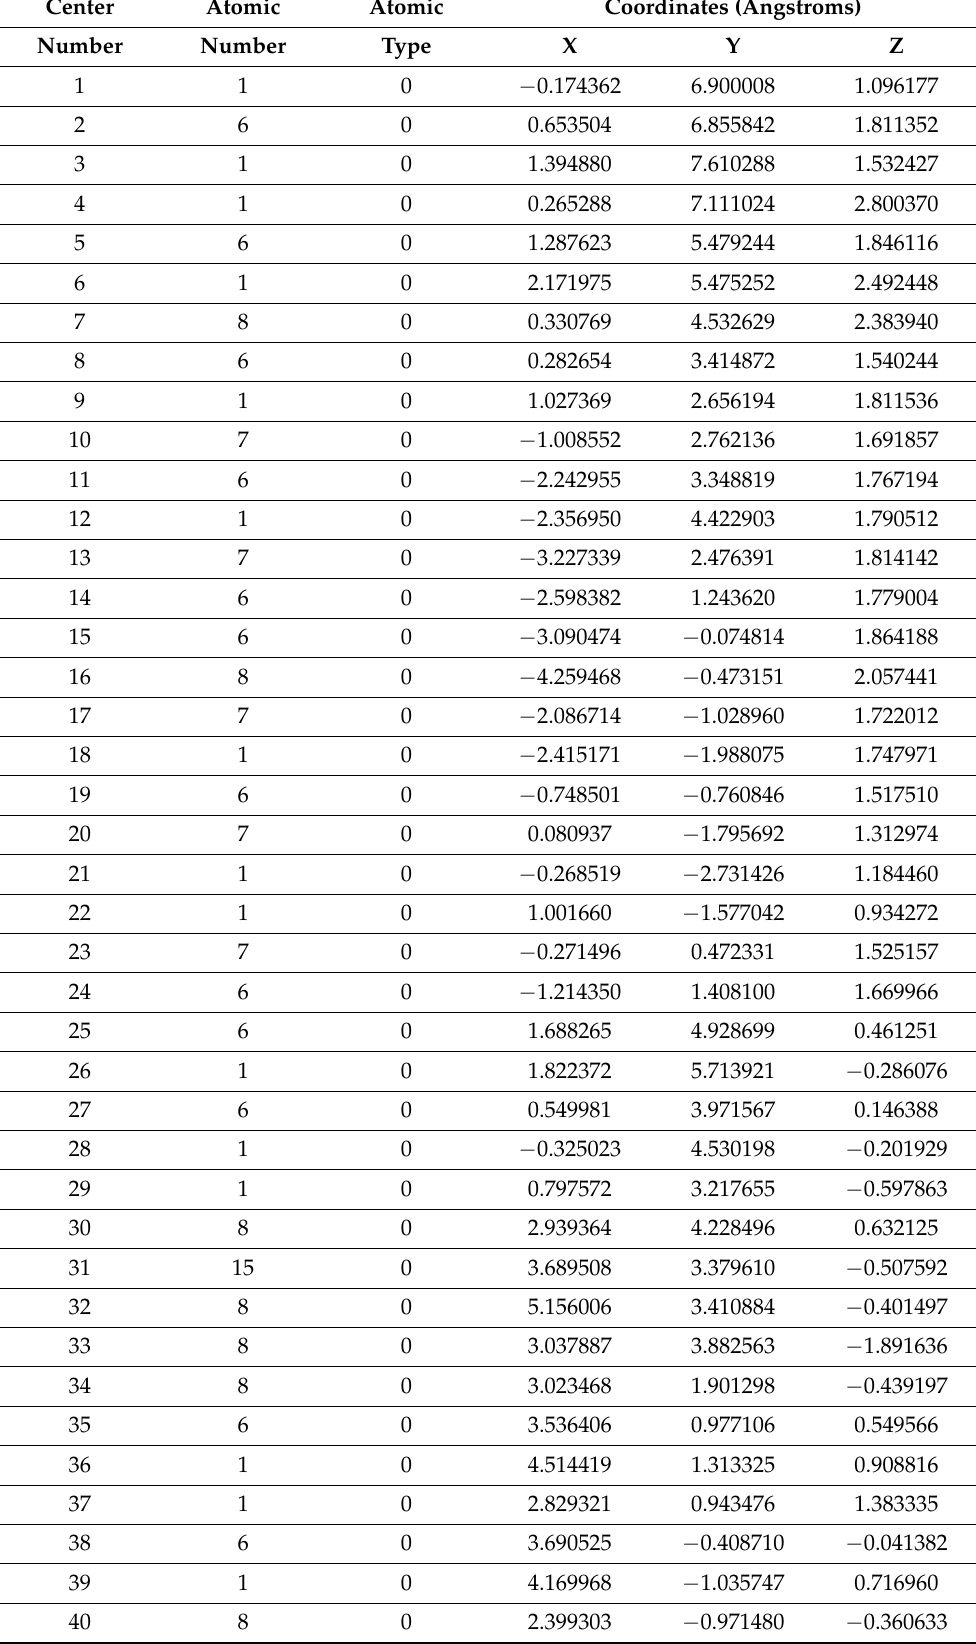
Table A7. Complex MgI 3 LiII 2 with nucleotide triplet GAA. Standard